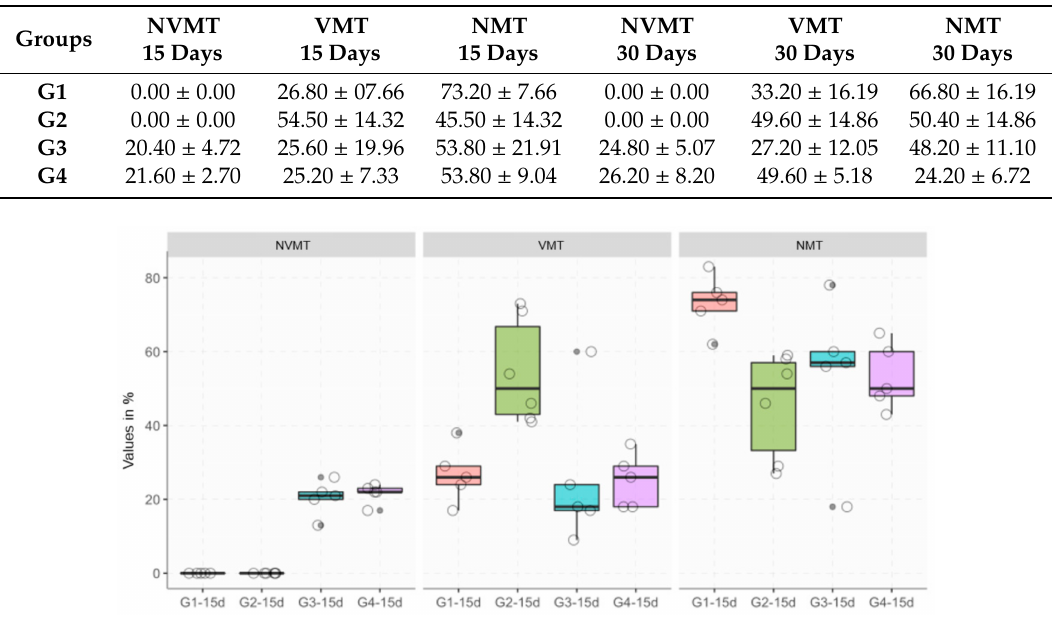
Figure 7. Boxplot of histomorphometric data across the 15-day